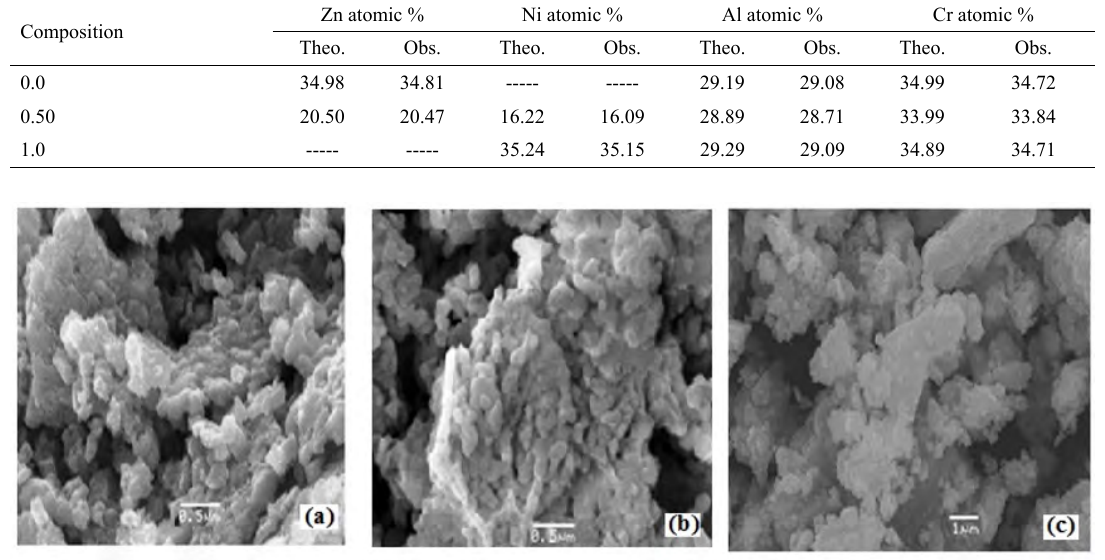
Figure 4. (a-c) SEM images of Zn